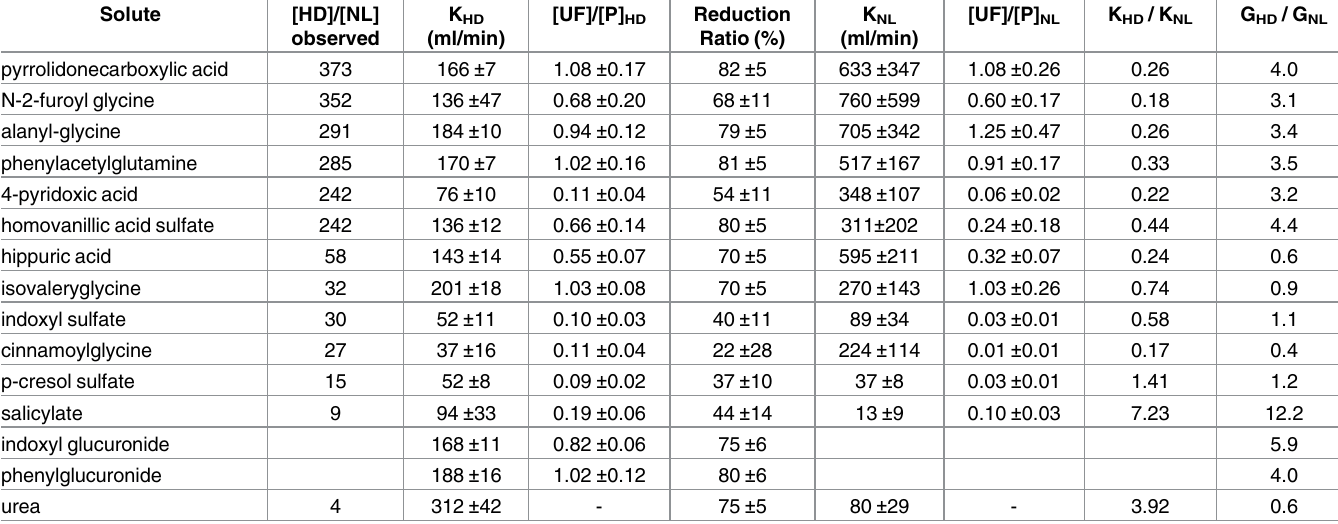
Table 1. Kinetic behavior of chemically identified solutes. Solute